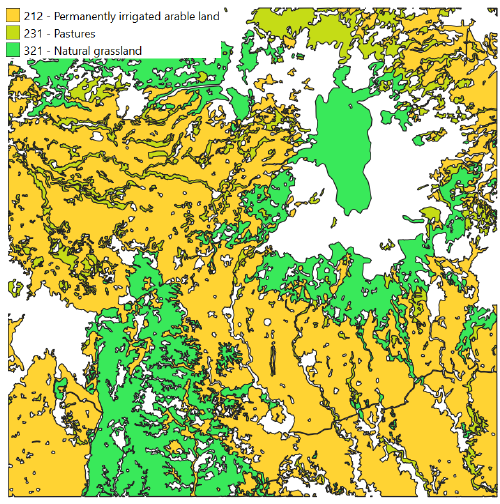
Figure 4. Turkey: distribution of LC classes.